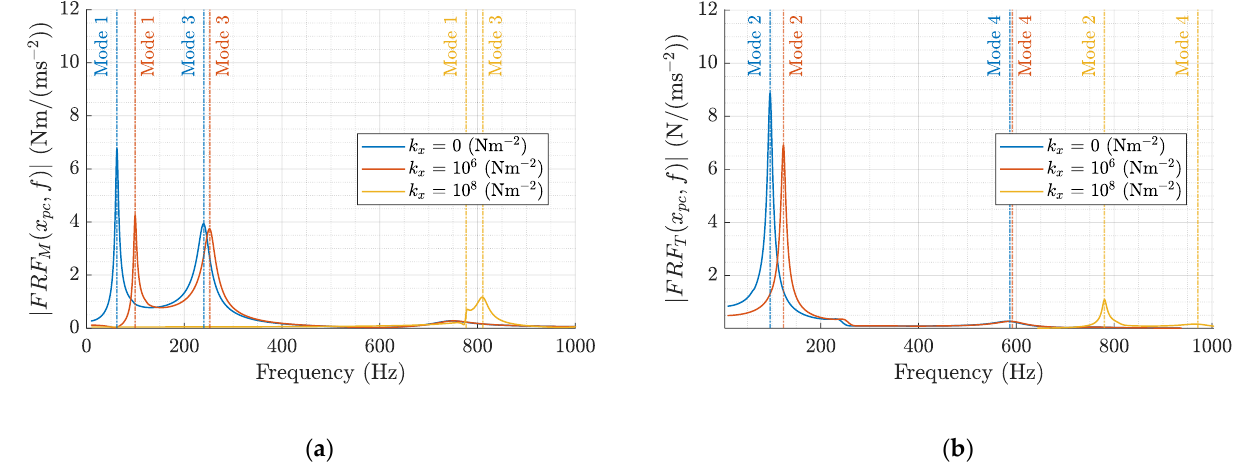
Figure 9. ( a ) Magnitude of the bending moment FRF; ( b ) magnitude of the shear force FRF.